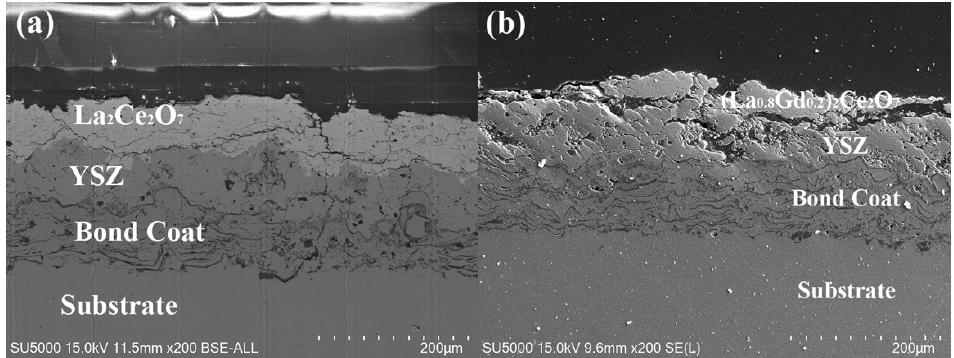
Figure 13. Cross-section morphologies of the failed thermal barrier coatings: ( a ) LC/YSZ, and ( b ) LGC/YSZ.